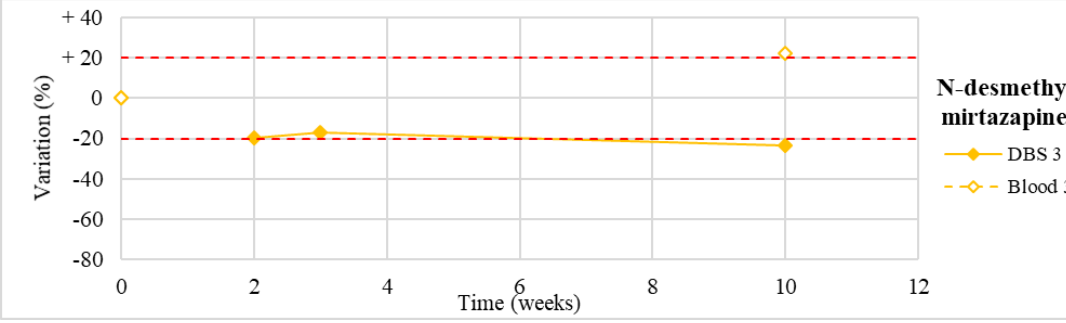
Figure 5. Long-term stability of N-desmethylmirtazapine ( n = 1) in DBSs stored at room temperature and in blood stored at −20 °C (T0–T4).